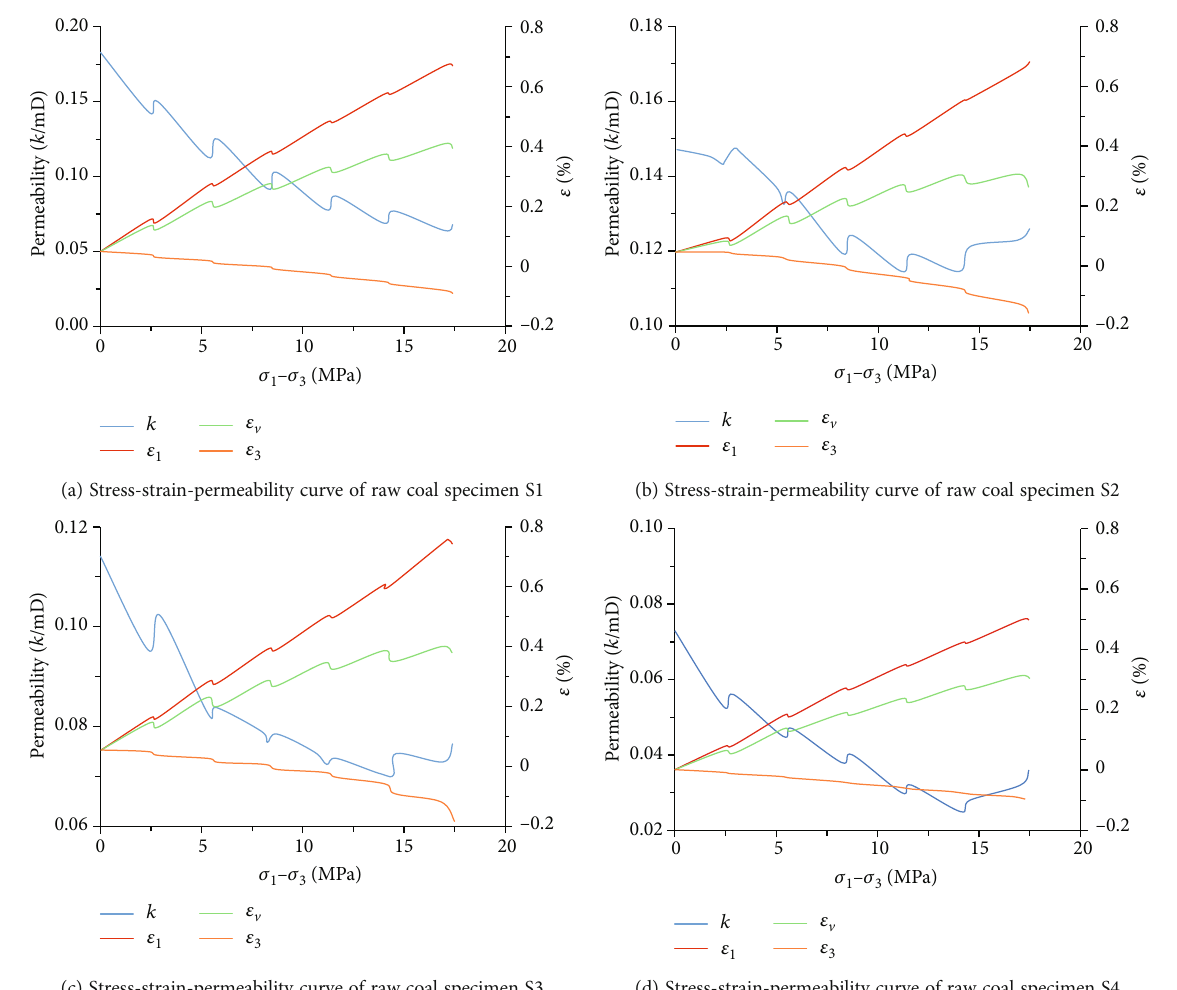
(d) Stress-strain-permeability curve of raw coal specimen S4 Figure 4: Stress-strain-permeability curve of raw coal under variable axial pressure loading